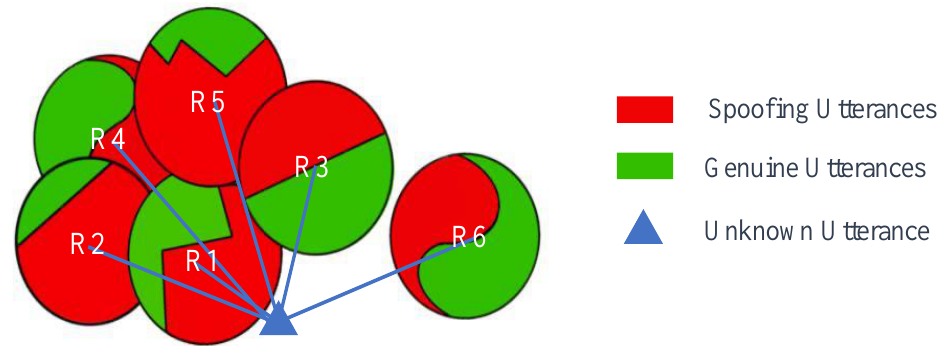
Figure 3. Architecture of the proposed spoofing countermeasure based on local classification subproblems.